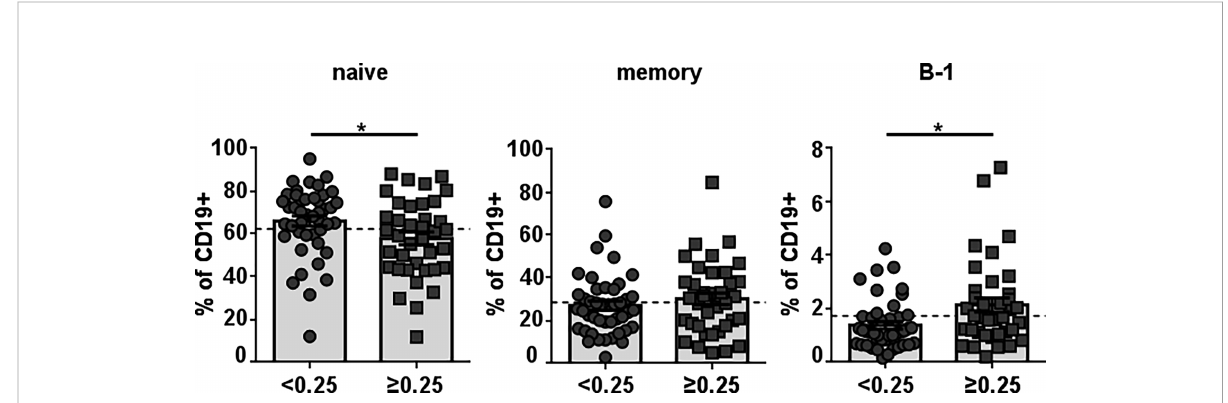
FIGURE 1 Frequency of different B-cell populations in healthy individuals according to their level of anti-Neu5GcGM3 IgM antibodies. Plasma samples from 78 healthy donors were screened by ELISA for anti-Neu5GcGM3 IgM. Samples diluted 1:50 were assessed on plates coated with Neu5GcGM3 using biotinylated goat anti-human IgM, followed by the addition of an alkaline phosphatase-streptavidin complex. Samples with absorbance values ≥ 0.25 were considered positive to Neu5GcGM3. Percentages of circulating mature/naive (CD19+CD20+CD38 low/int CD27- CD43-), memory (CD19+CD20+CD38 low/int CD27+CD43-) and B-1 (CD19+CD20+CD38 low/int CD27+CD43+) within the CD19+ population in healthy donors without (D.O. < 0.25) or with (D.O. ≥ 0.25) anti-Neu5GcGM3 IgM were analyzed by fl ow cytometry. *p ≤ 0.05, Mann – Whitney U-test. Each symbol represents an individual healthy donor and the bars represent the means. Dotted lines represent the mean of the total memory, mature/naive or B-1 cell population,